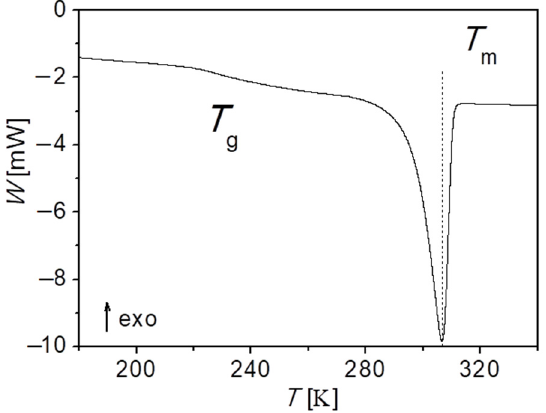
Figure 9. DSC thermogram for PEG-upy obtained at a heating rate of 10 K/min, showing the glass transition and melting temperatures with increasing temperature, respectively.